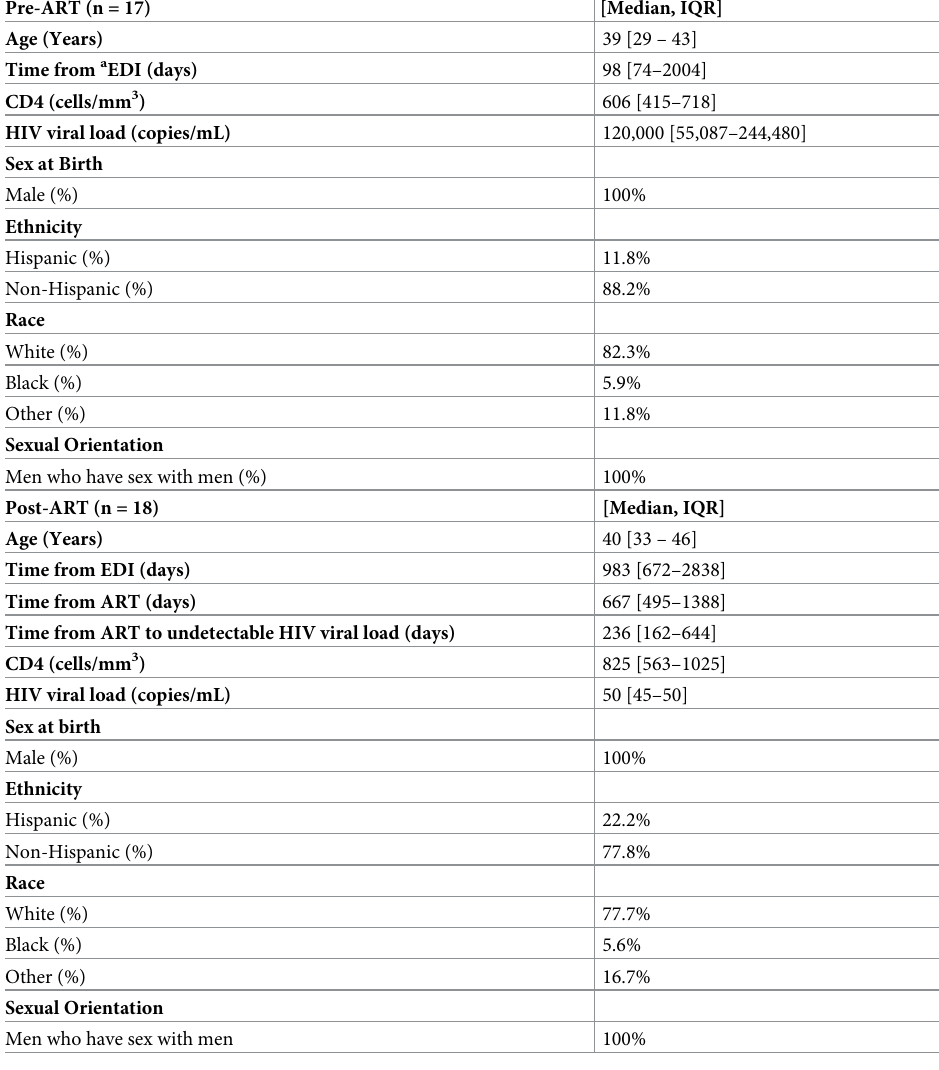
Table 1. Clinical Characteristics of HIV positive